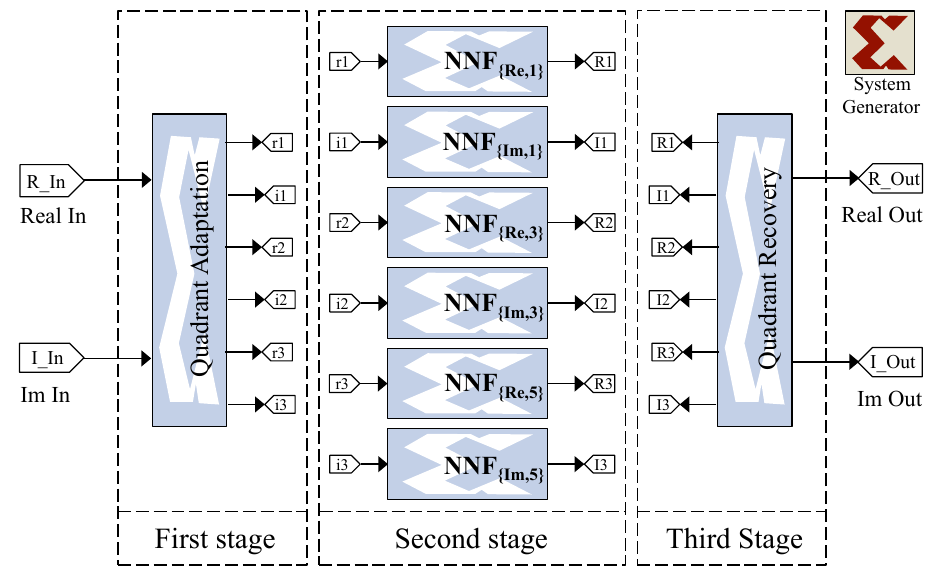
Figure 10. Implemented frequency-domain NN using a Xilinx system